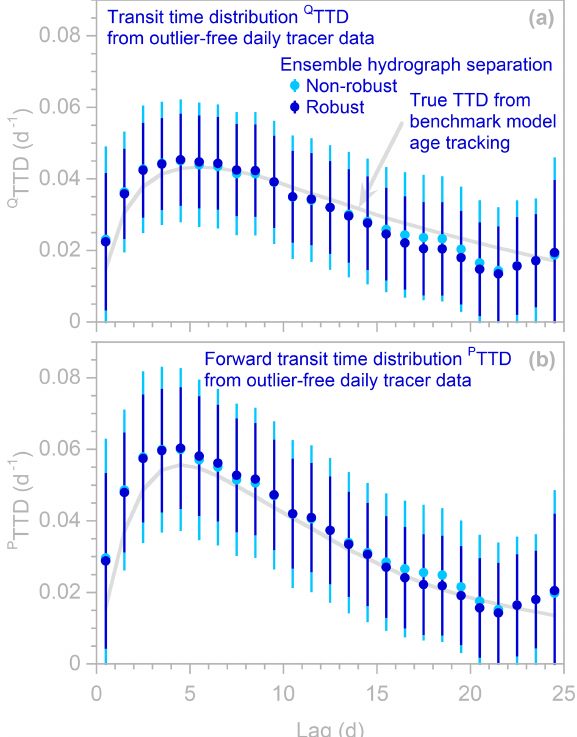
Figure 6. Humped transit time distributions ( Q TTDs) and forward transit time distributions (transit time distributions of precipitation, P TTDs), as estimated by ensemble hydrograph separation from syn- thetic benchmark tracer time series. Symbols show ensemble hy- drograph separation results obtained with and without robust esti- mation (dark and light symbols, respectively); error bars indicate 1 standard error. Many light blue symbols are obscured because they are overprinted by dark blue symbols. The light gray lines indicate the true TTD, as calculated from water age tracking in the bench- mark model. The TTDs calculated from the synthetic tracer time se- ries follow these gray lines, but the error bars indicate that the stan- dard errors are overestimated by large factors. Benchmark model parameters are S u, ref = 50mm, S l, ref = 50mm, b u = 5, b l = 2, and η = 0.01. The model is driven by the same time series of precipita- tion rates and δ 18 O values shown in Fig. 1 and used in Figs. 2–5.